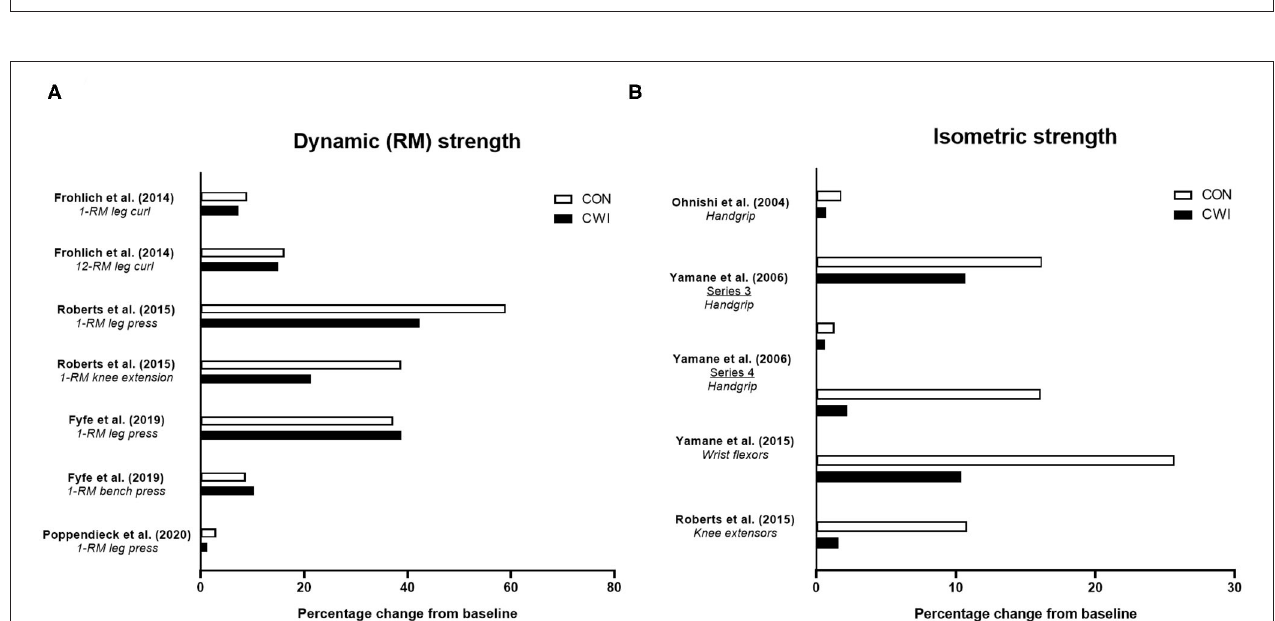
FIGURE 1 | Summary of studies investigating the effects of post-exercise cold water immersion (CWI) on muscle hypertrophic adaptations to resistance training, including effects (shown as mean percentage changes from baseline to post-training) on measures of whole-muscle cross-sectional area (CSA; A ), muscle fiber CSA (B) , and lean body mass (C) .